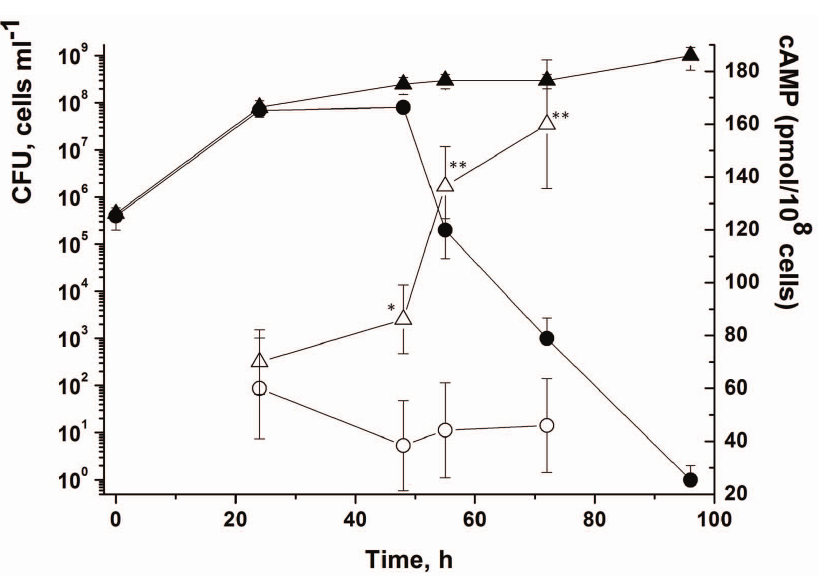
Figure 1. Hyper-expression of the MSMEG_4279 adenylyl cyclase abolishes the transition of M.smegmatis cells to the NC state. M. smegmatis cells were inoculated into modified (lacking potassium ions) Hartman’s–de Bont (mHdeB) medium and incubated with strong aeration 200 rpm) at 37 u C. Strains harbouring pMind (empty plasmid vector) or pMindAc (adenylyl cyclase hyper-expression plasmid) are denoted with circles and triangles, respectively. Samples were withdrawn periodically for CFU determination (closed symbols) and intracellular cAMP content (open symbols). This experiment was repeated three times with similar results; the error bars represent the standard error of the mean. Asterisks indicate significant difference in cAMP concentration between pMindAC cells and pMind cells by Student’s t-test.